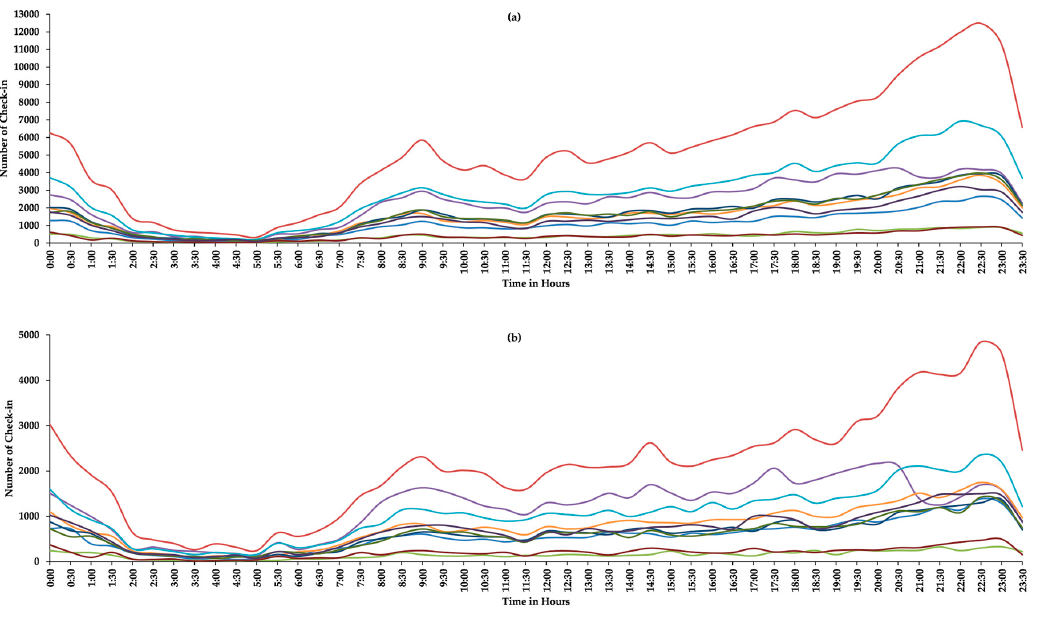
Figure 10. Temporal trend of activities in Shanghai: (a) overall, (b) men, (c) and women. Figure 11 reveals the kernel densities of check-ins related to activities in the districts of Shanghai, where the suburban districts (Baoshan and Minhang) had a high distribution of check-ins associated with Food and Drink and Residence compared to the city center districts, supporting the results of Figure 9.